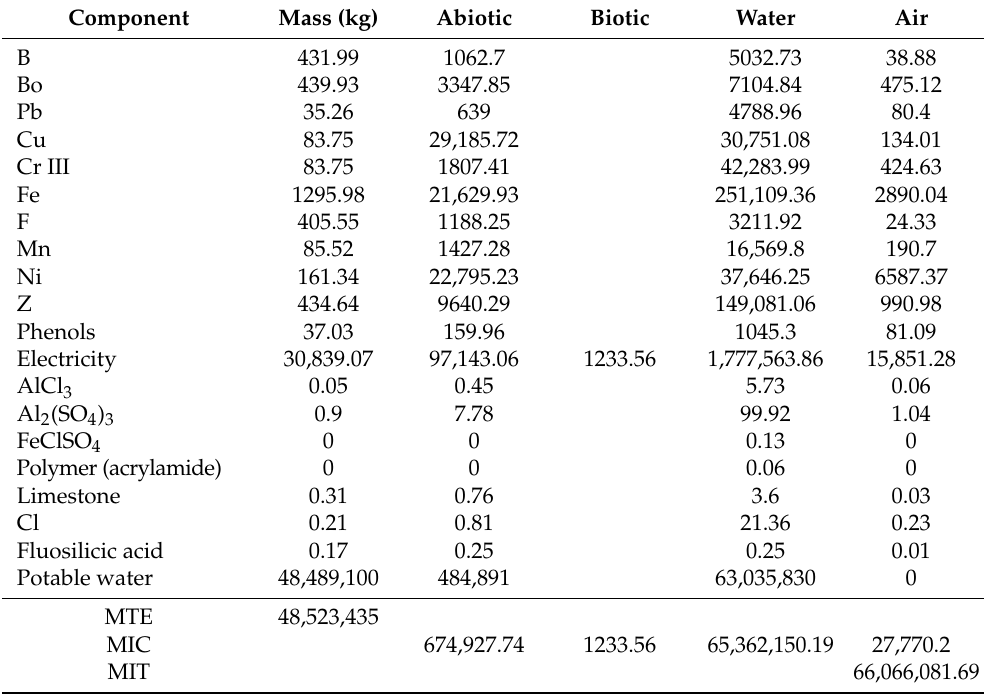
Table 7. Analysis of environmental impact reduction.